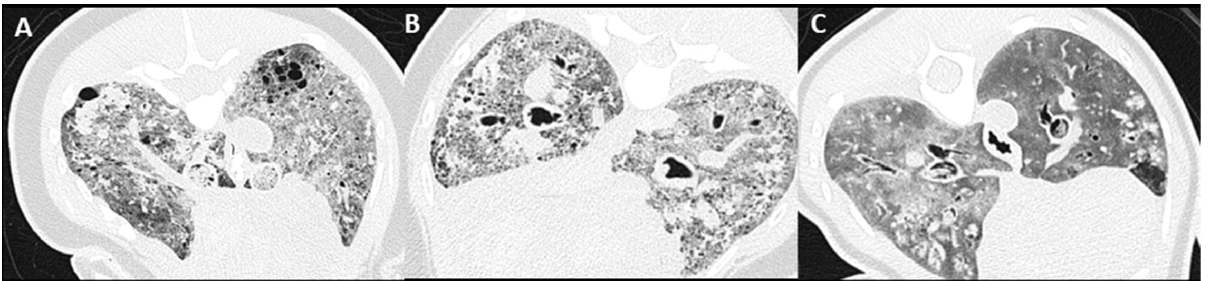
Figure 6. Patterns of pulmonary air entrapment on PMCT. From left to right: ( A ) Peripheral bullous bronchiectasis, ( B ) diffusely distributed small, rounded gas attenuations throughout the pulmonary parenchyma, including the vasculature, and ( C ) mosaic pattern with peripheral areas of decreased parenchymal attenuation.